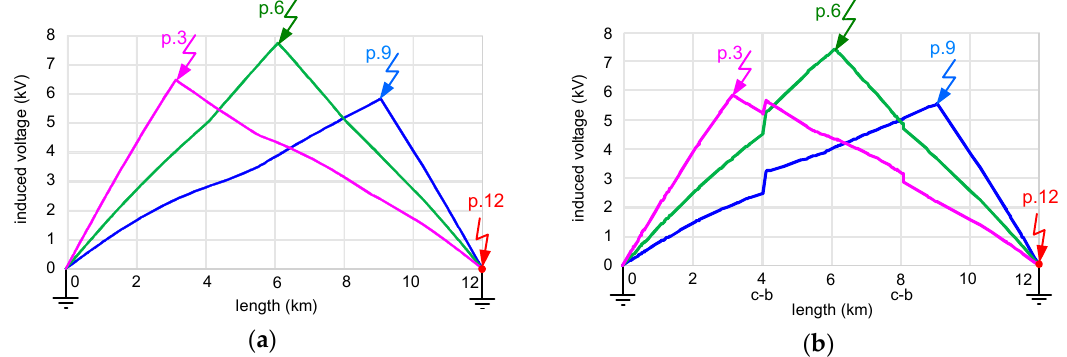
Figure 10. Induced sheath voltages as a function of the cable line length, in case of the line-to-earth fault in the characteristic points (p.3, p.6, p.9 or p.12): ( a ) both-ends bonding; ( b ) cross bonding (c-b) in p.4 and p.8.